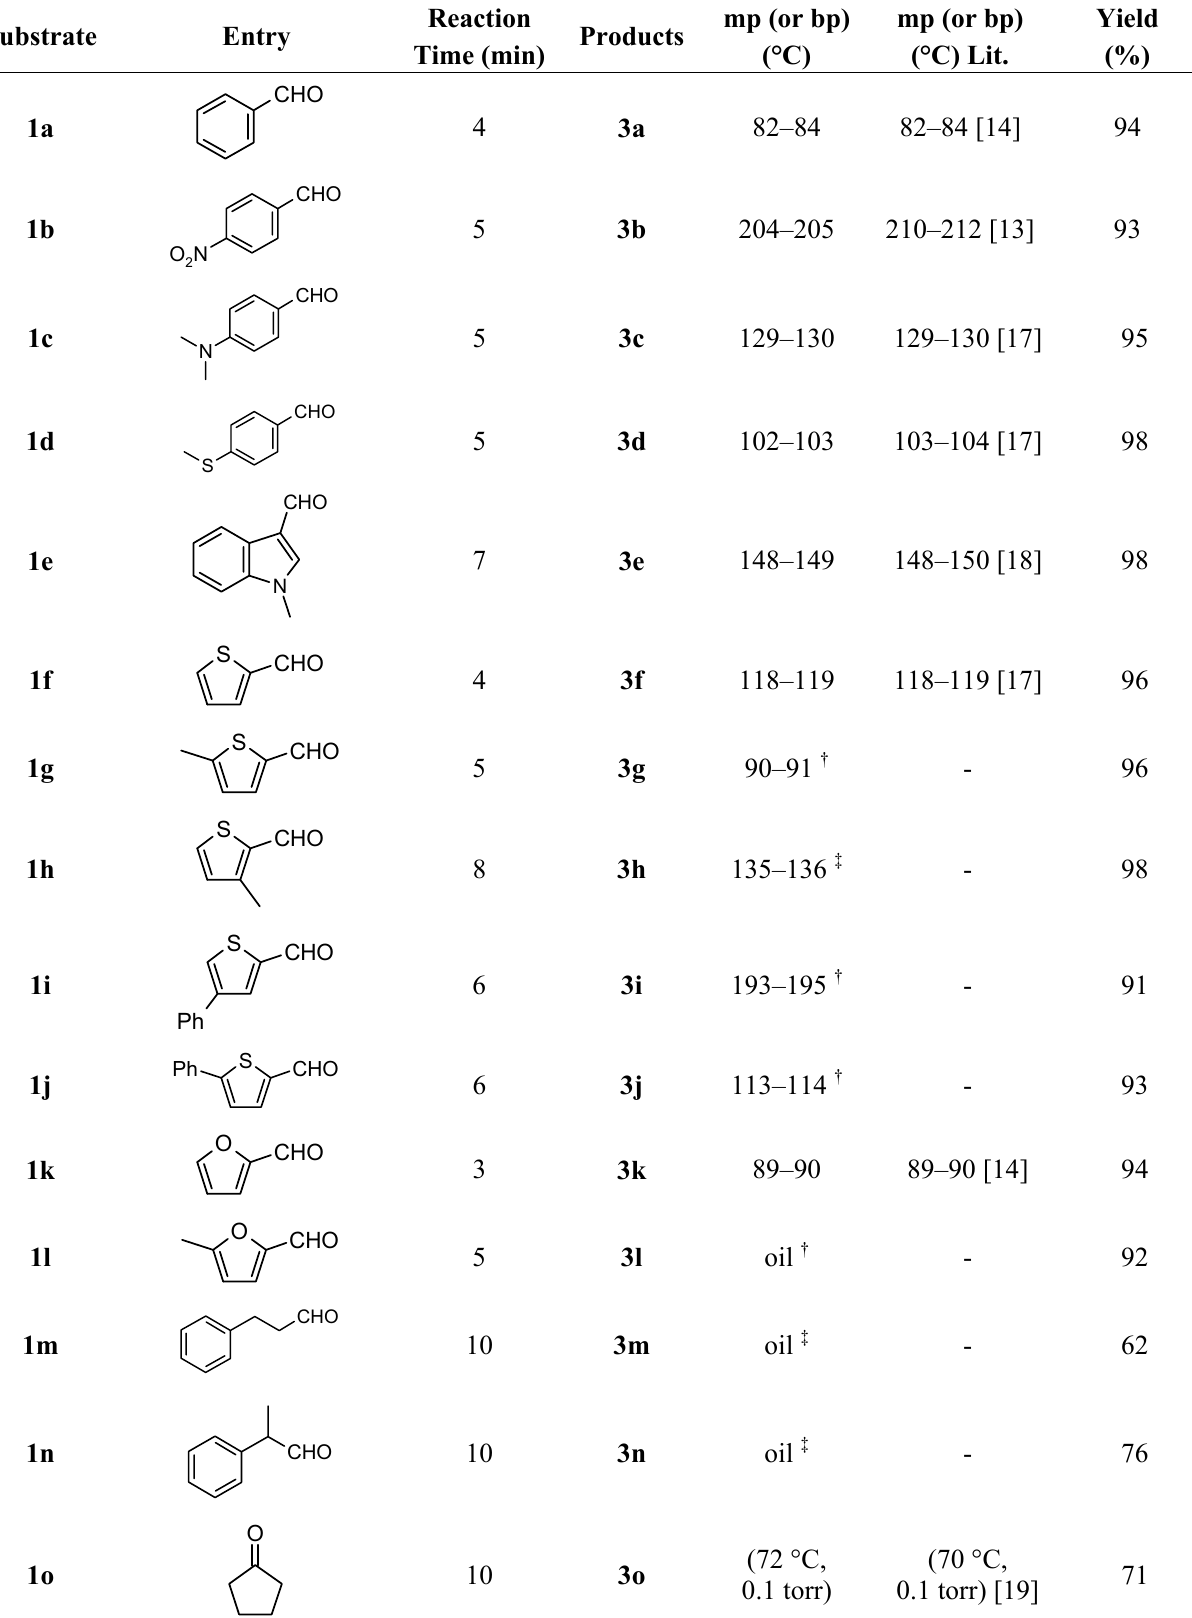
Table 1. Reaction time, melting points and